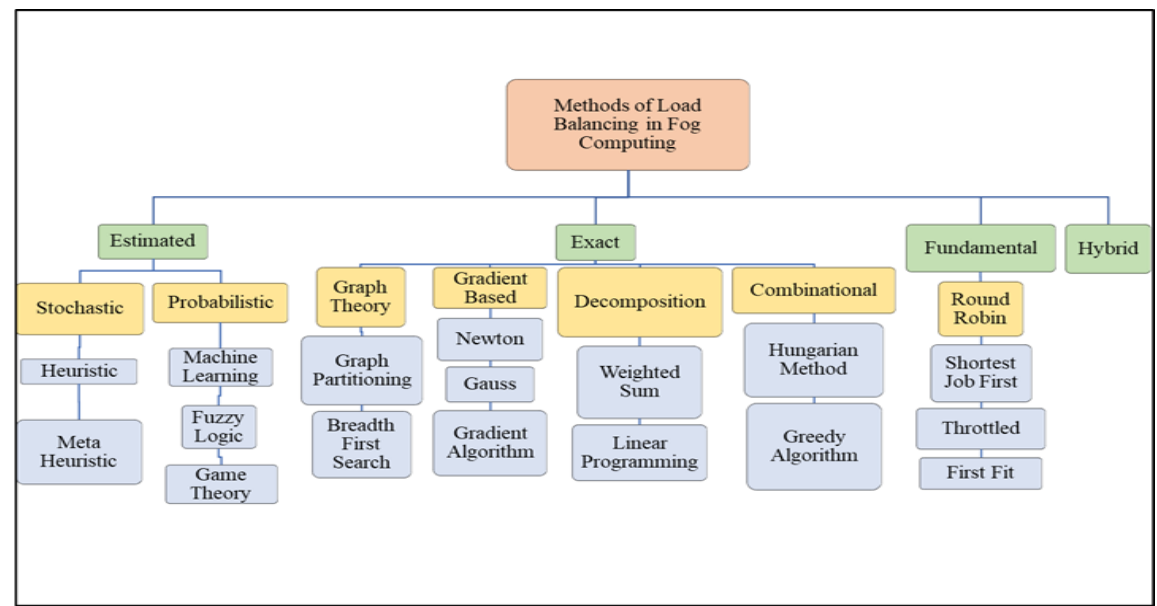
Figure 1. Methods of load balancing in fog computing.